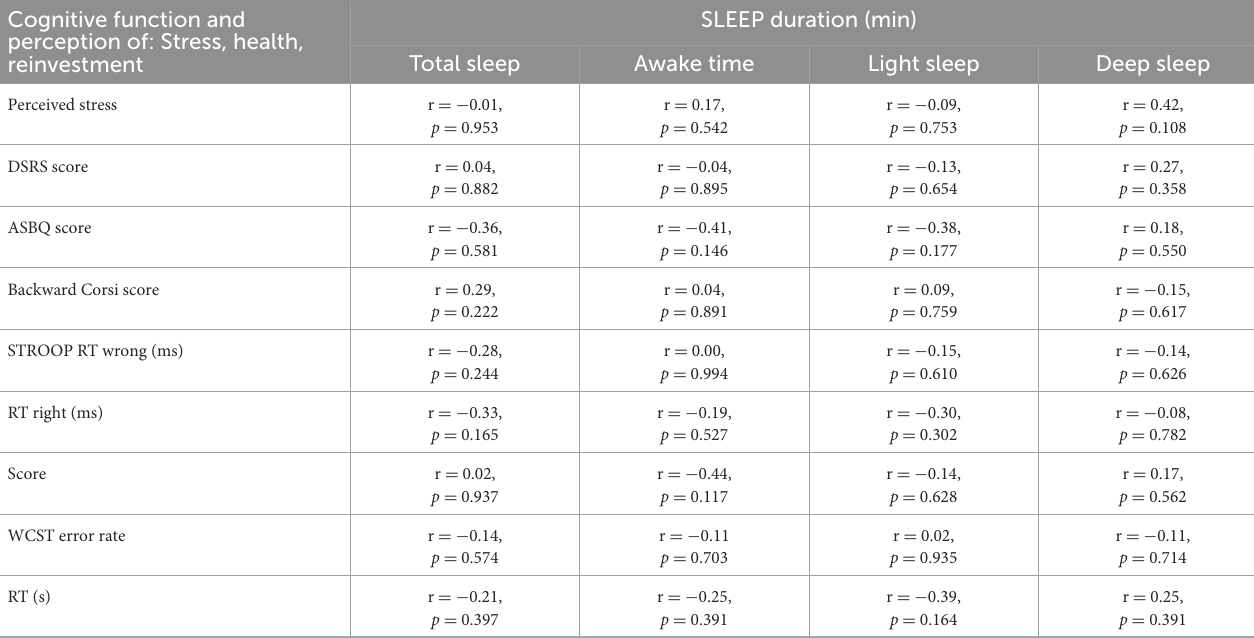
SLEEP duration (min) Total sleep Awake time Light sleep Deep sleep